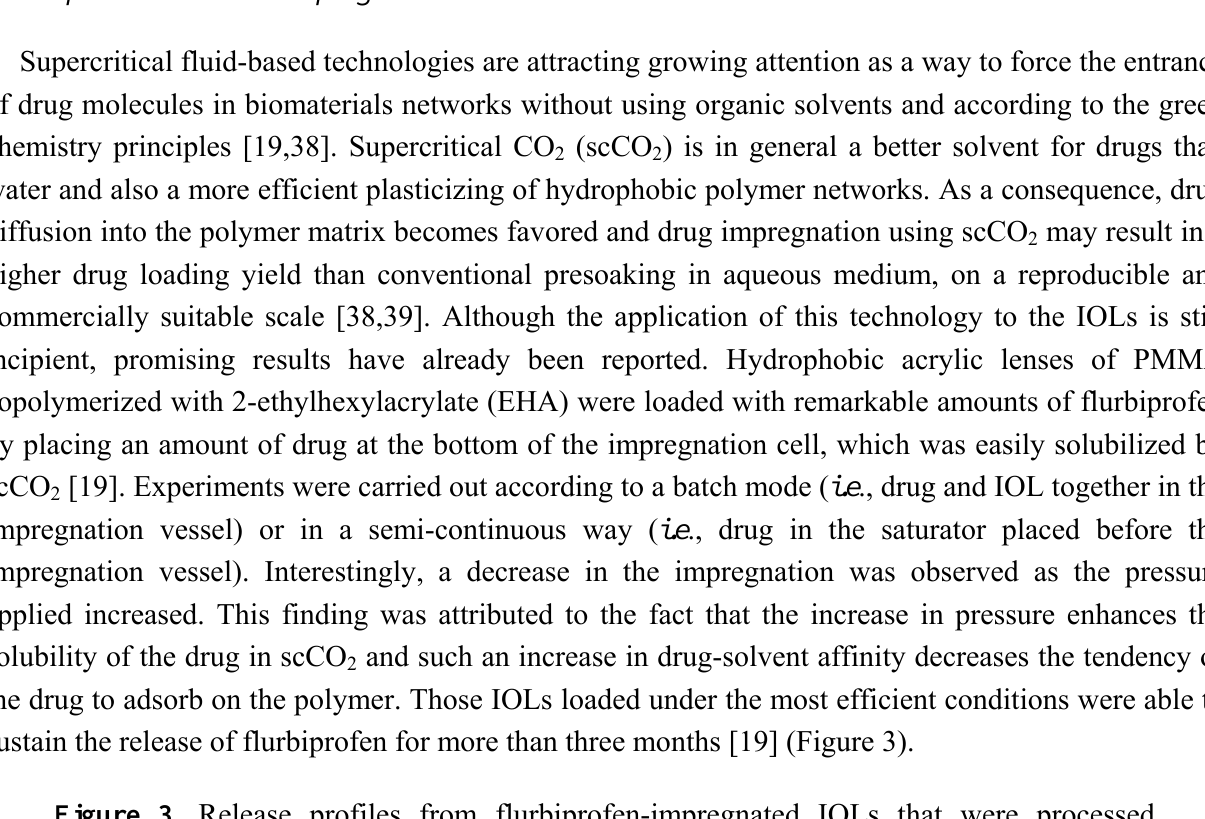
Figure 3. Release profiles from flurbiprofen-impregnated IOLs that were processed according to a batch or a semi-continuous way. The percentages of impregnation, defined as the relative quantity of drug in an impregnated sample, were 0.82% and 0.22% respectively. Reproduced from reference [19] with permission of